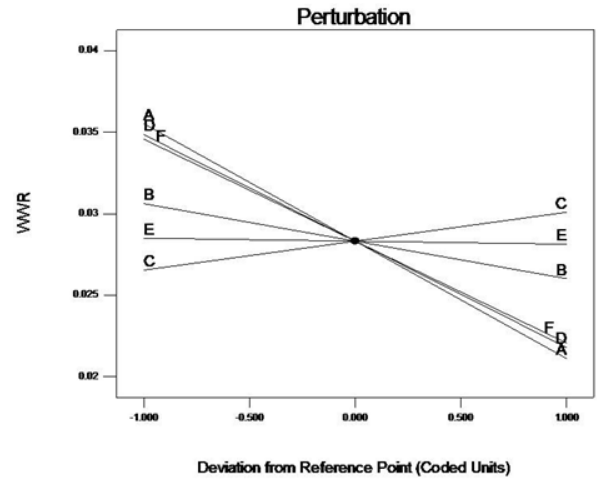
Figure 6: Perturbation plot showing the effect of individual parame- ters on